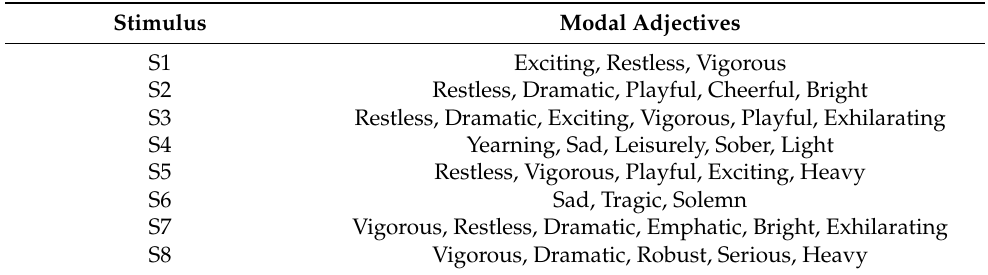
Table 4. The adjectives chosen by more than one participant in response to each tactile composition (S1–S8) as shown in Figure